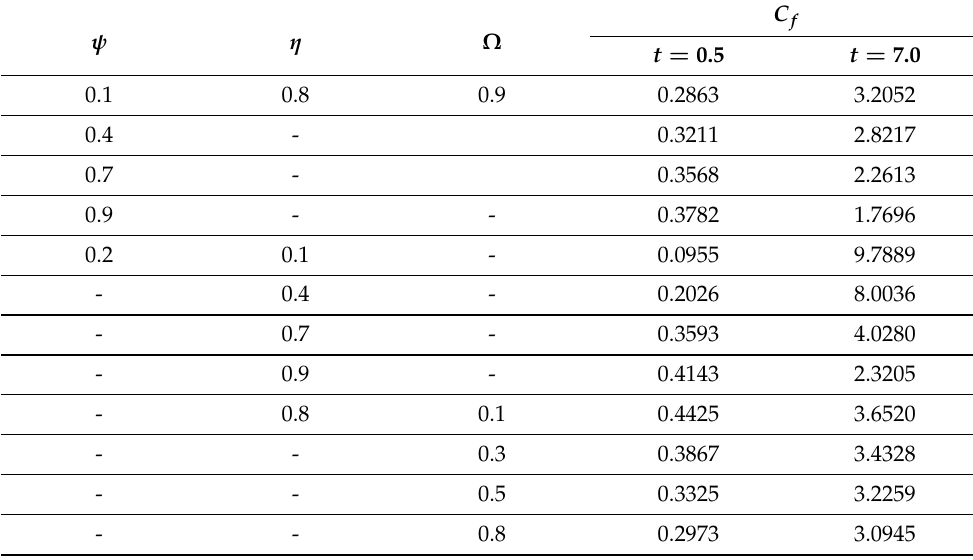
Table 7. Investigation of C f for various values of ψ , η , and Ω